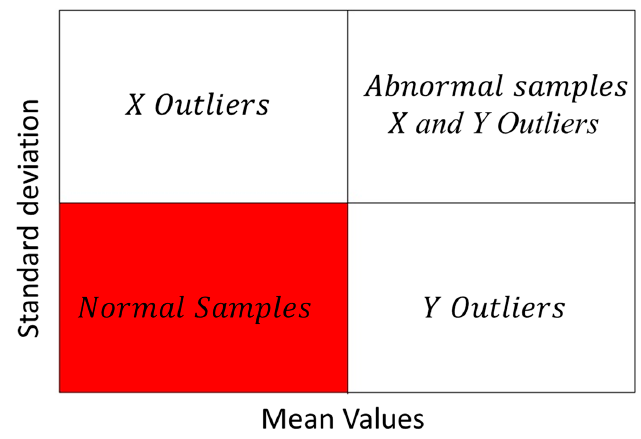
Figure 5. The result of standard deviation versus mean value for each sample calculated by Monte-Carlo cross-validation method. Samples in the red region are identified as normal, whereas the others are outliers.